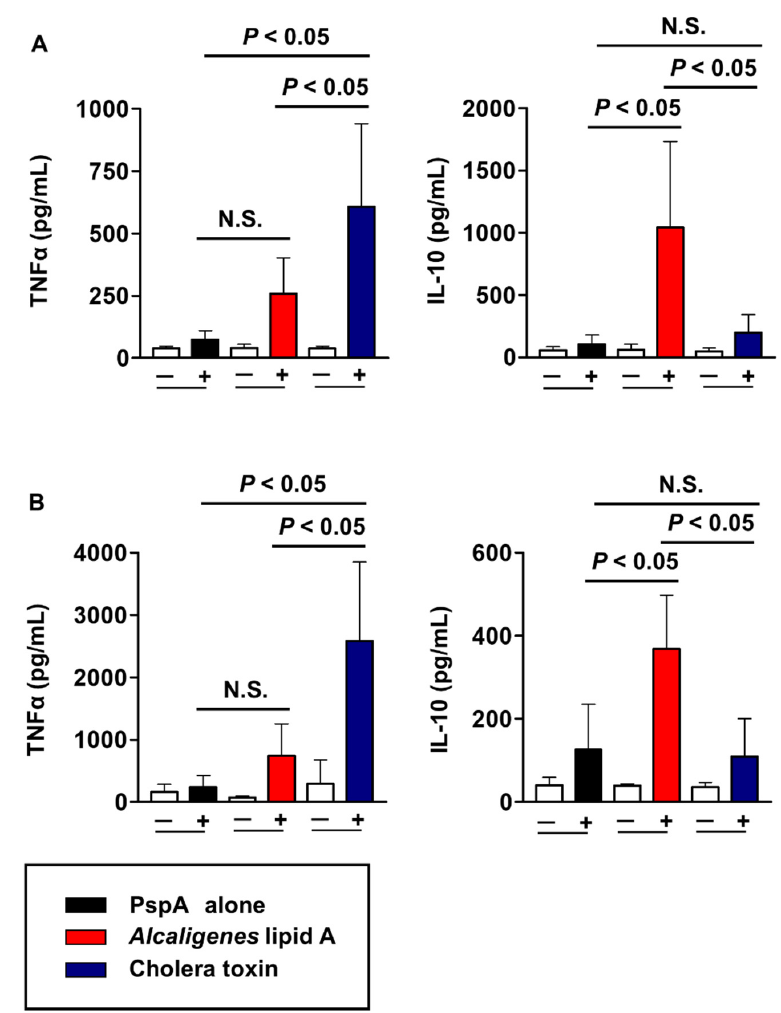
Figure 4. Alcaligenes lipid A suppresses a pro-inflammatory cytokine and enhances an anti-inflammatory cytokine. CD4 + T cells were isolated from the cervical lymph nodes ( A ) and spleen ( B ) of immunized mice and then cultured with irradiated antigen-presenting cells in the presence ( + ) or absence ( − ), respectively, of PspA. Culture supernatants were collected after 4 days to measure the concentrations of TNF α and IL-10. Data are representative of two independent experiments and are expressed as means ± SD ( n = 4 per group). Statistical significance was evaluated by using one-way ANOVA at p < 0.05; N.S., not statistically significant.